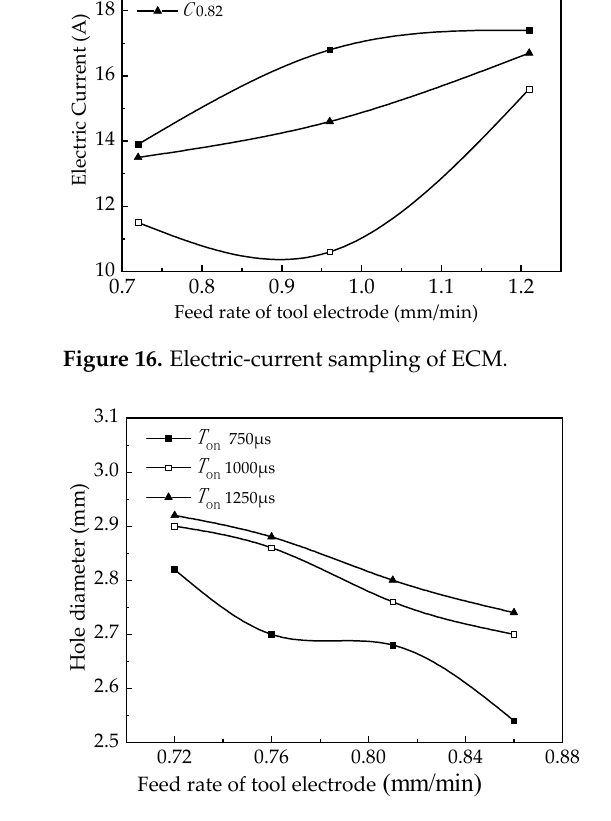
Figure 17. Influence of feed rate of tool electrode on the diameter of processed hole.